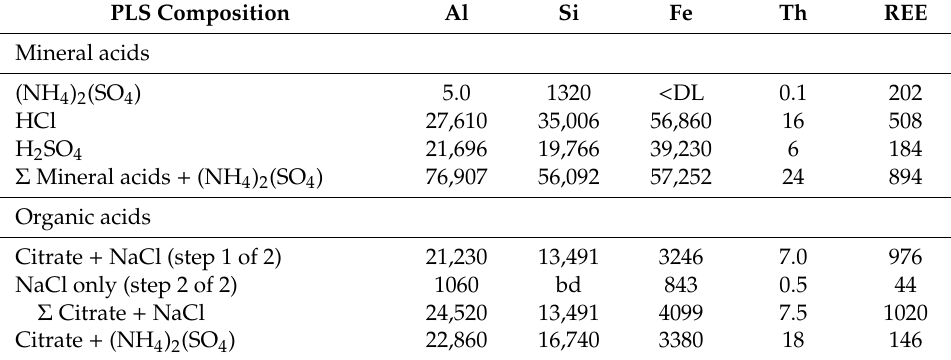
Table 8. Concentration (in µ g / L) of Al, Si, Fe, Th, and REE in mineral acid and organic acid PLS generated from leaching of Middle Kittanning underclay (sample UC-02). Values are adjusted to mass of material